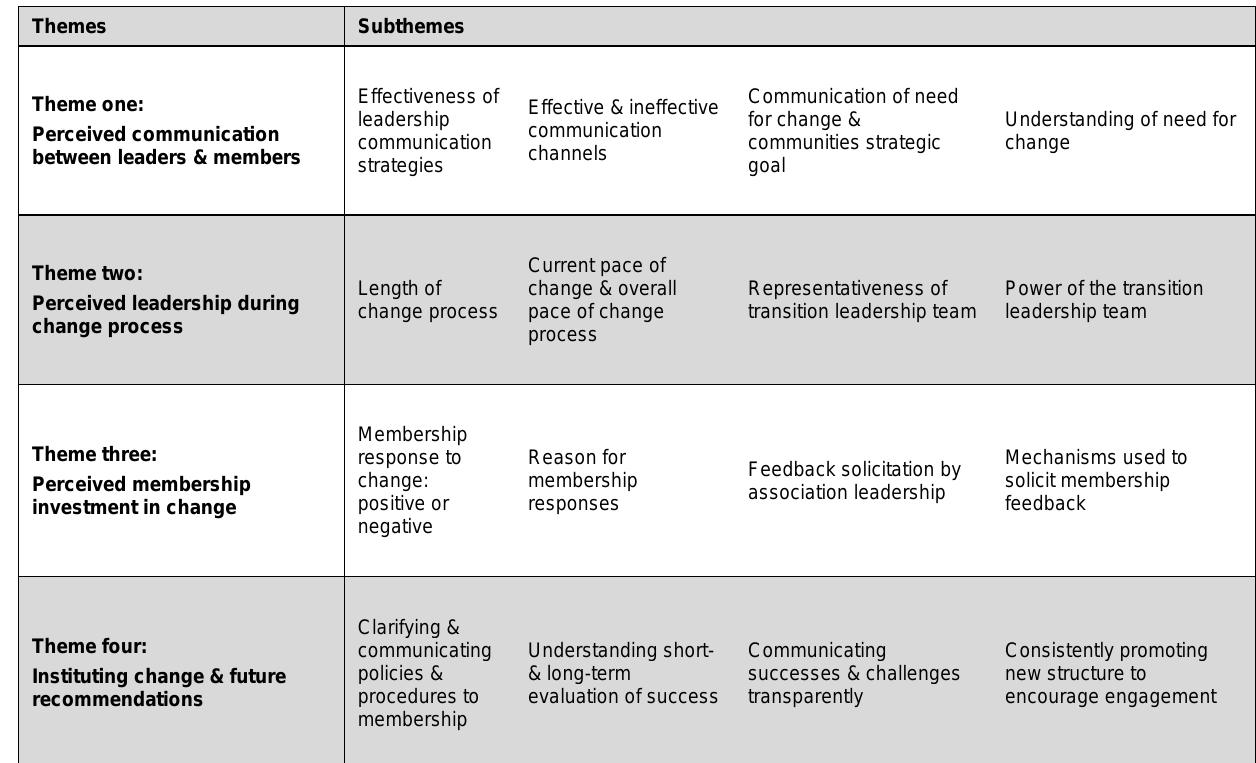
Table 1 Map of themes and subthemes identified during